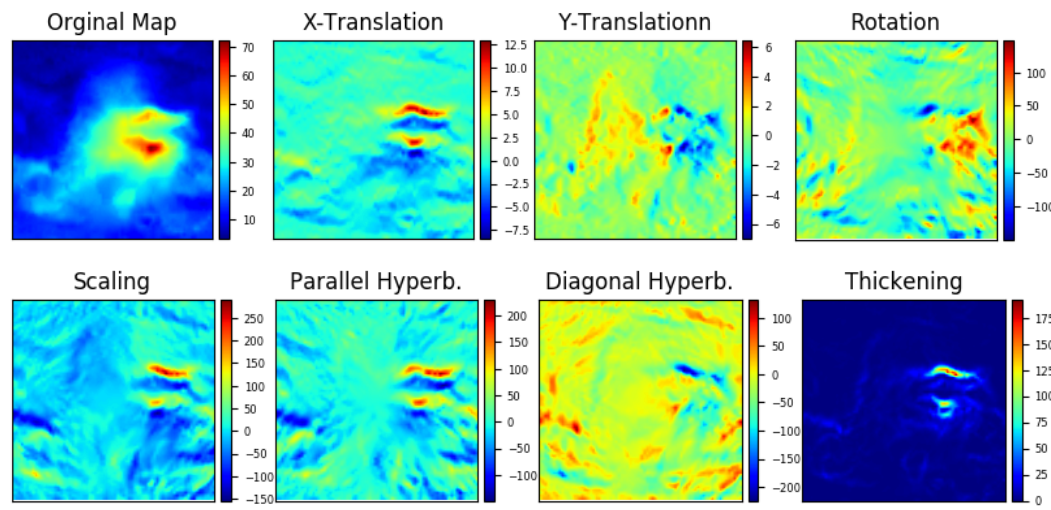
Figure 4. Components of the tangent space corresponding to a map observed at “2016-02-21 13:30:00”. Transformation of a Map along the Tangent